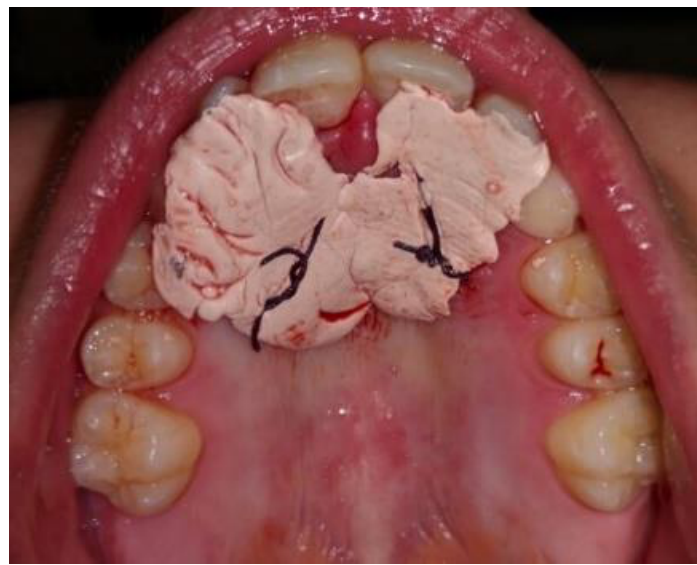
Figure 4. Application of periodontal pack.